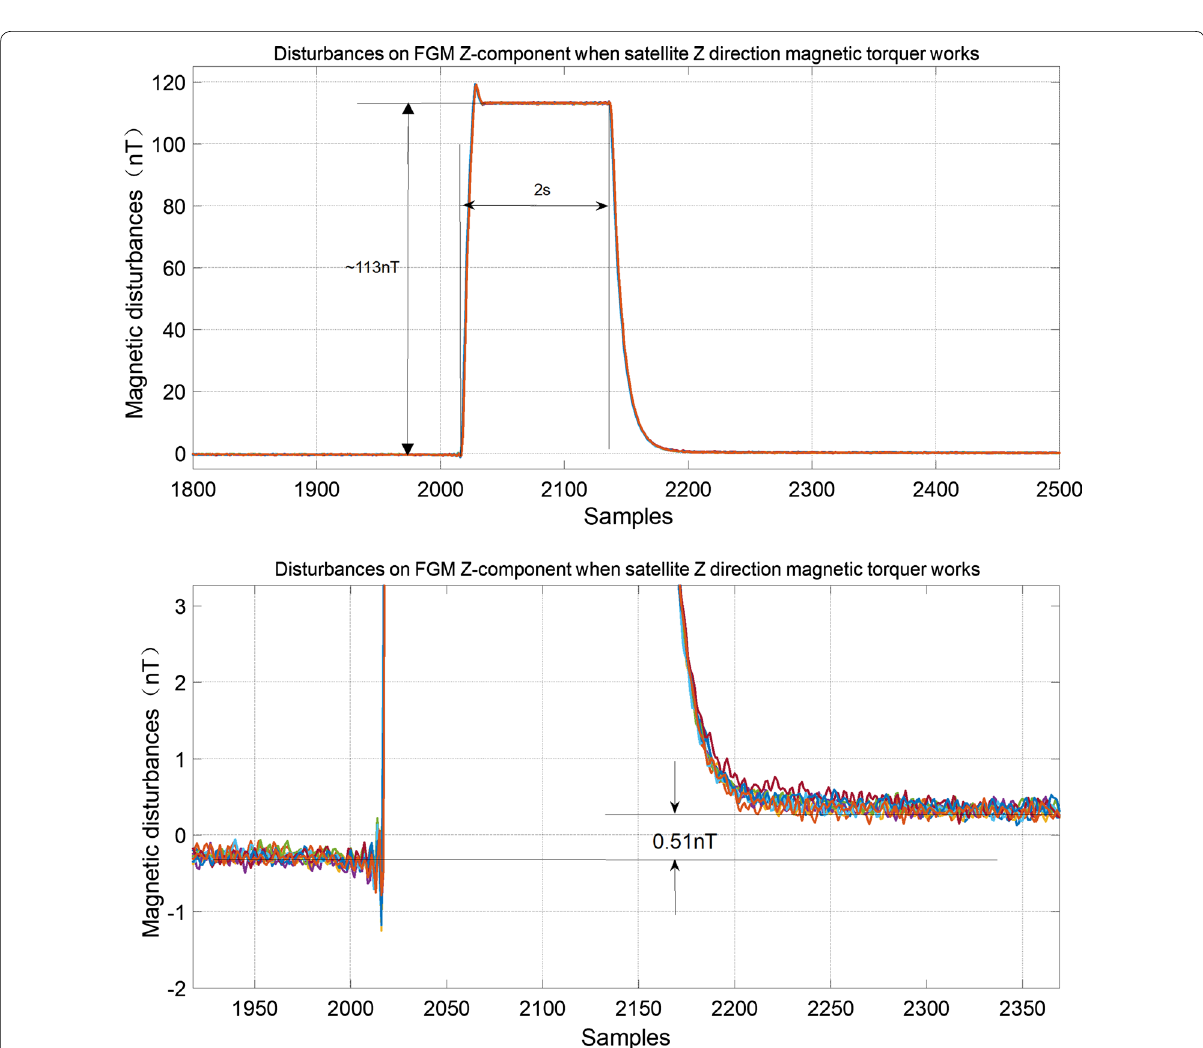
Fig. 15 The magnetic field disturbances on FGM measurements. a The magnetic field disturbances on FGM2 z component when the magnetic torque operates. Nine data series are shown. The magnetic torquer utilizes the time pulse-width modulation mode, so the interference strengths match well every times it works. b The residues under different magnetization directions vary. With the ground calibration data, this difference can be accurately